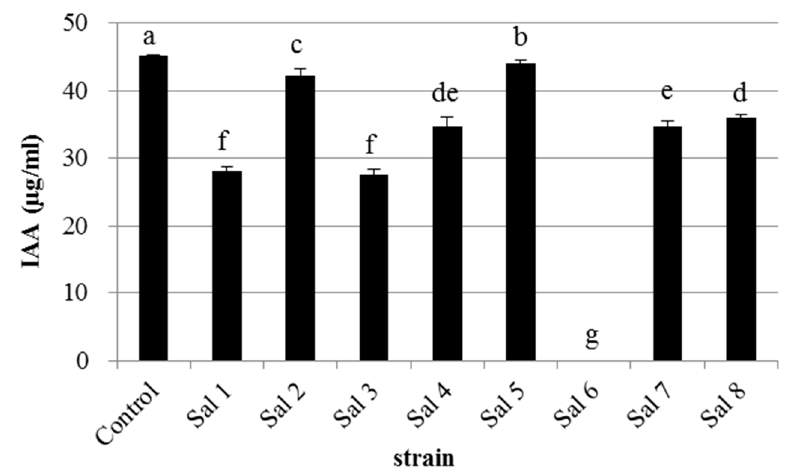
Figure 1. Degradation of indole-3-acetic acid (IAA) by sweet potato endophytes in N + MR medium. The bars represent standard deviation (n = 3) and different letters indicate significant differences at P < 0.01 by Tukey’s test.